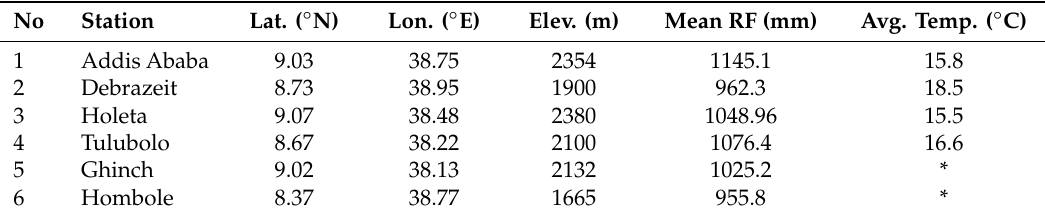
Table 1. General information of meteorological